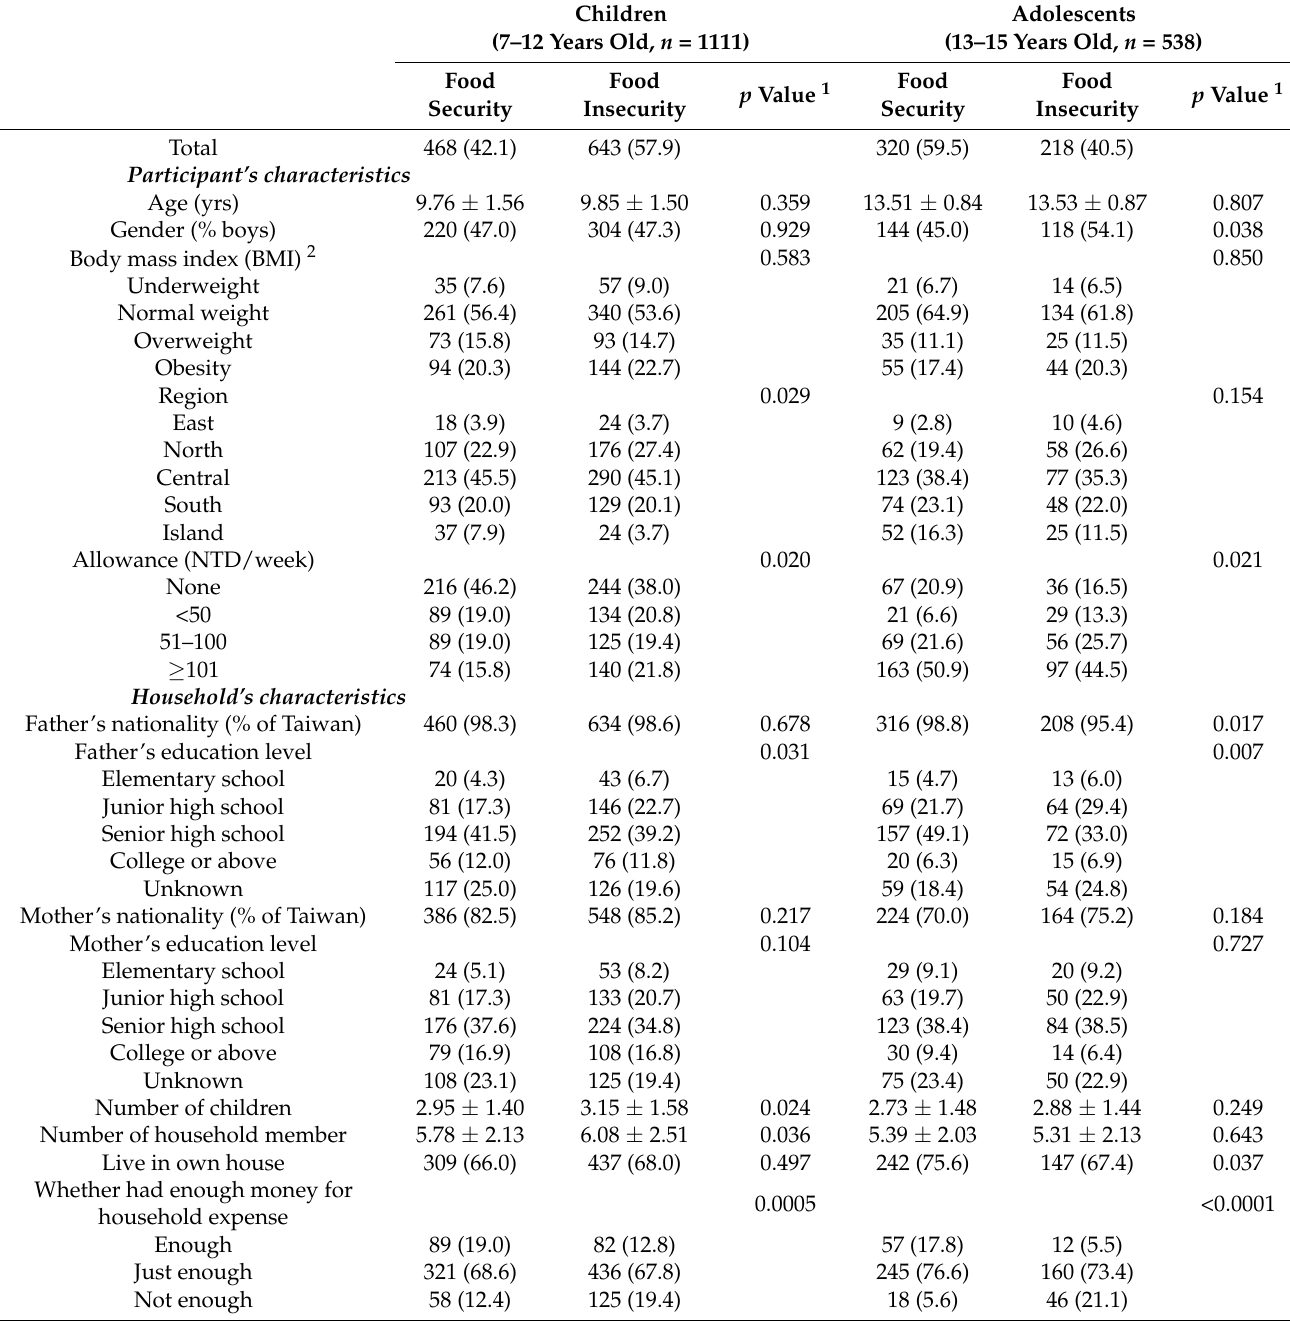
Table 1. Baseline characteristics of participants by food security among children and adolescents. ( n =